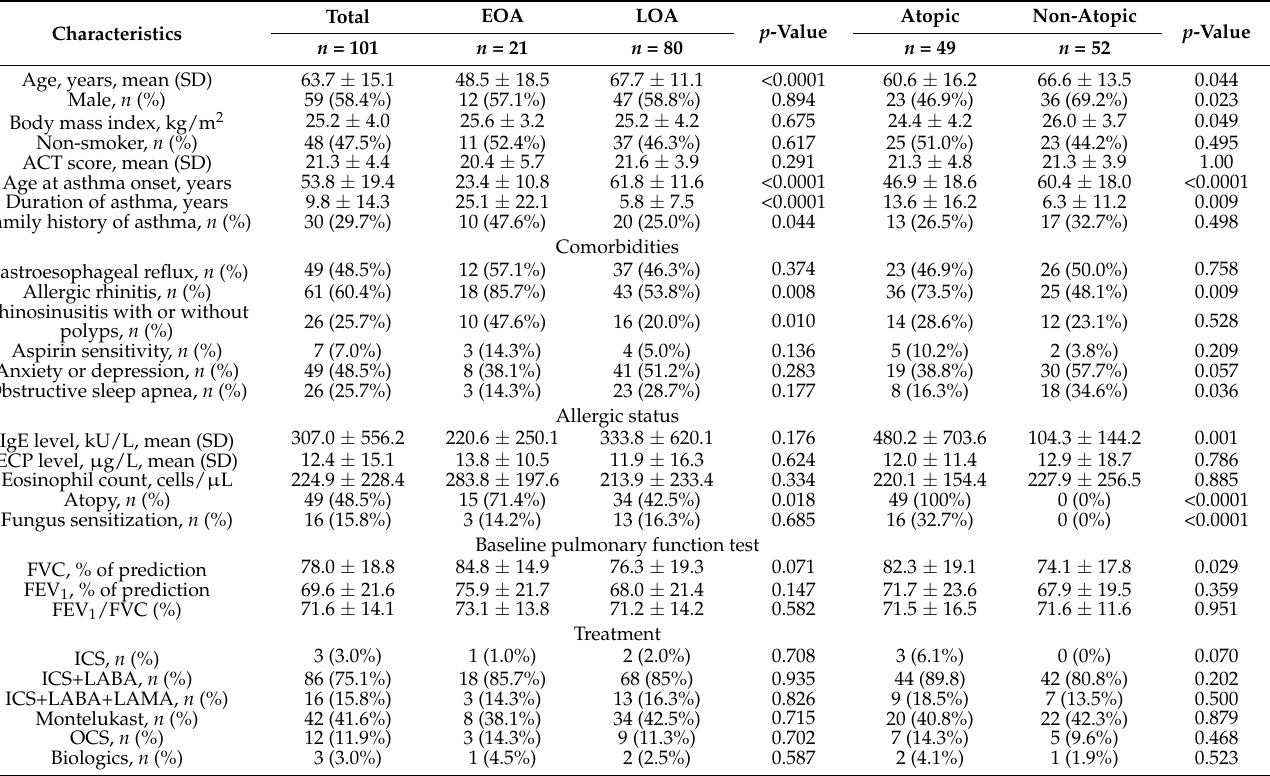
Table 1. Characteristics of patients with early-onset and late-onset